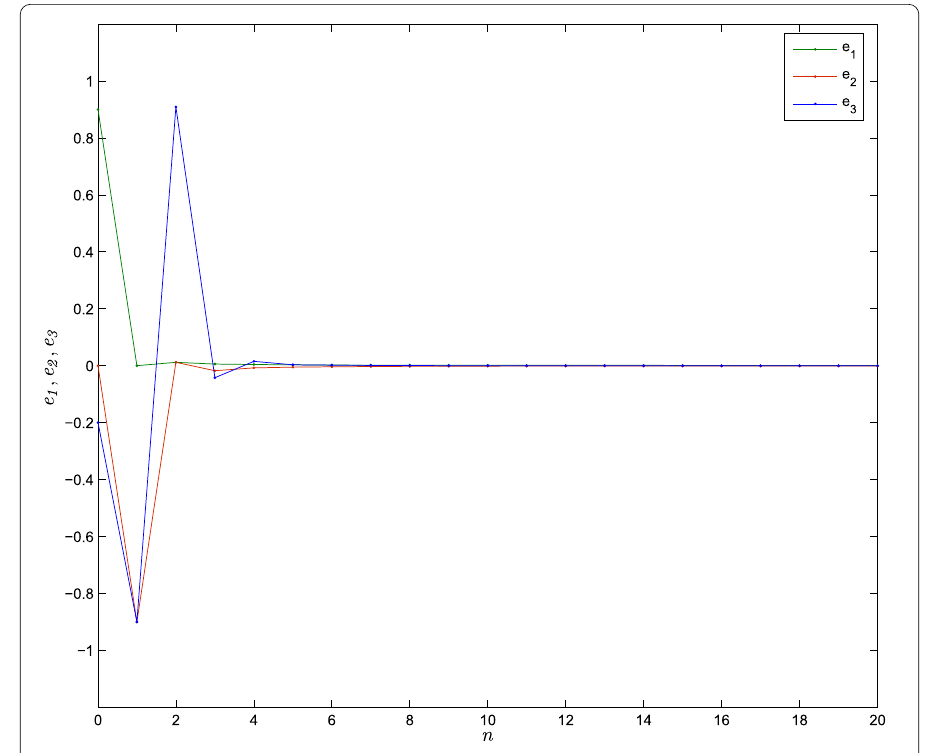
Figure 5 Synchronization error of the 2D-FoLDS and